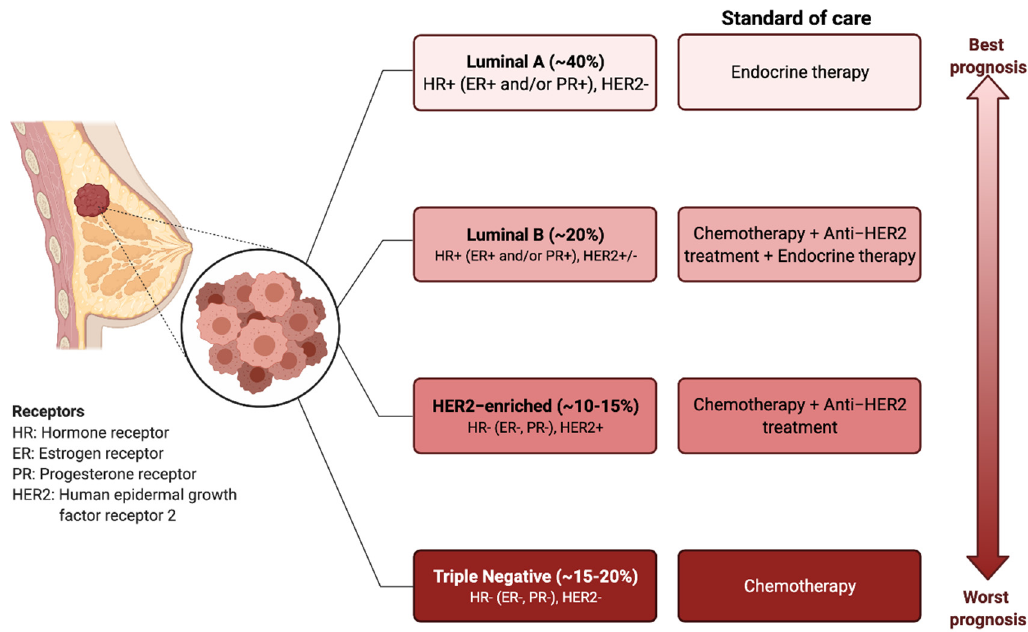
Figure 1. Breast cancer subtypes: prognosis and standard treatments. BC can be classified into four subtypes based on the expression of estrogen receptor (ER), progesterone receptor (PR), and human epidermal growth factor receptor 2 (HER2). Targeted and endocrine therapies are administered based on the molecular markers. The triple-negative breast cancer types (i.e., ER − , PR − , HER2 − ), have the worst prognosis and do not respond to the endocrine therapies or HER2 targeting agents. Chemotherapy is the only therapeutic regimen used.